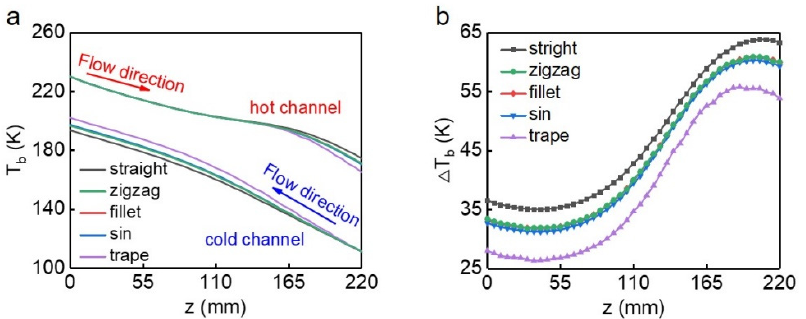
Figure 6. The distribution of ( a ) Bulk temperature of hot and cold fluids and ( b ) Temperature difference along the flow direction among five channels.